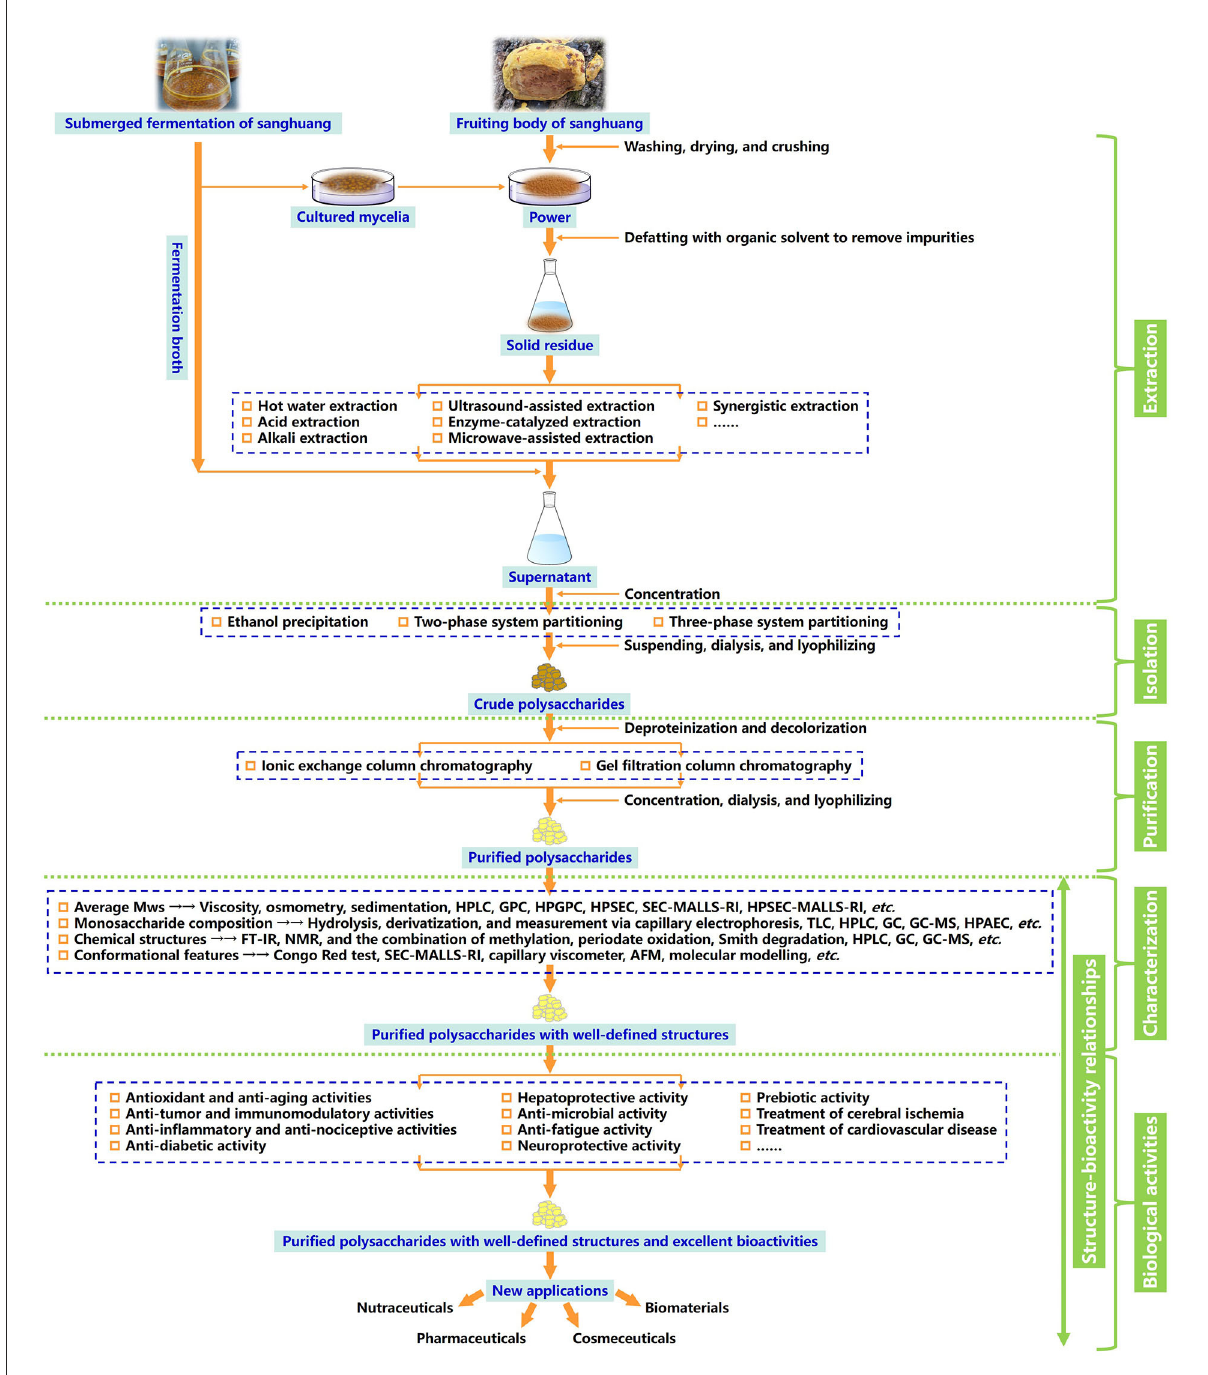
FIGURE1 Schematic illustration of preparation, structural elucidation, and bioactivity determination of the polysaccharides derived from the naturally medicinal fungal resources sanghuang.